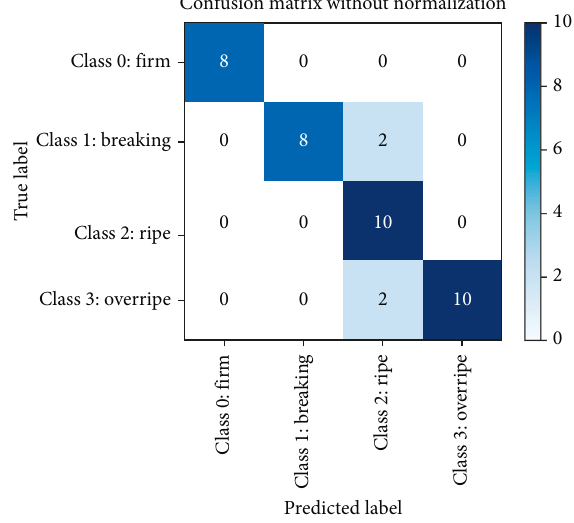
Figure 6: Plot of confusion matrix for test data.